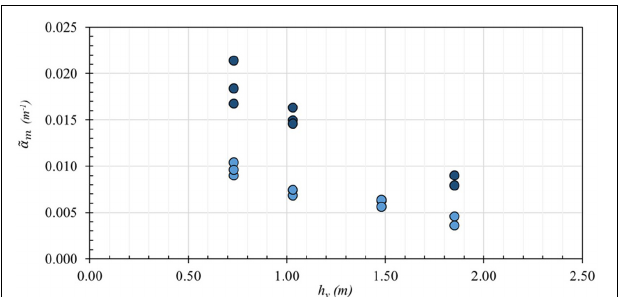
FIGURE 8 | Wave height decay coefficient, e α m versus the water depth at the vegetation, h v , for random wave cases for the high-density (HD) (dark blue circles) and low-density (LD) (intermediate blue circles)